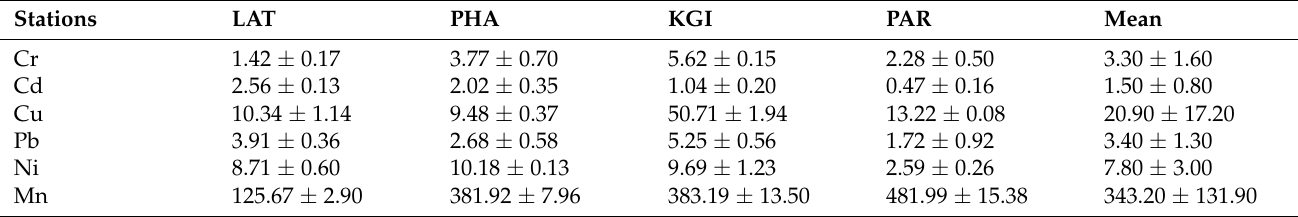
Table A4. Concentrations of Cr, Cd, Cu, Pb, Ni, Mn, and Zn (mg/kg ± S.D. in dry weight “DW”) (n = 3) in the roots of the species Colobanthus quitensis collected at the LAT, PHA, KGI and PAR stations with the mean concentrations of each metal. Stations